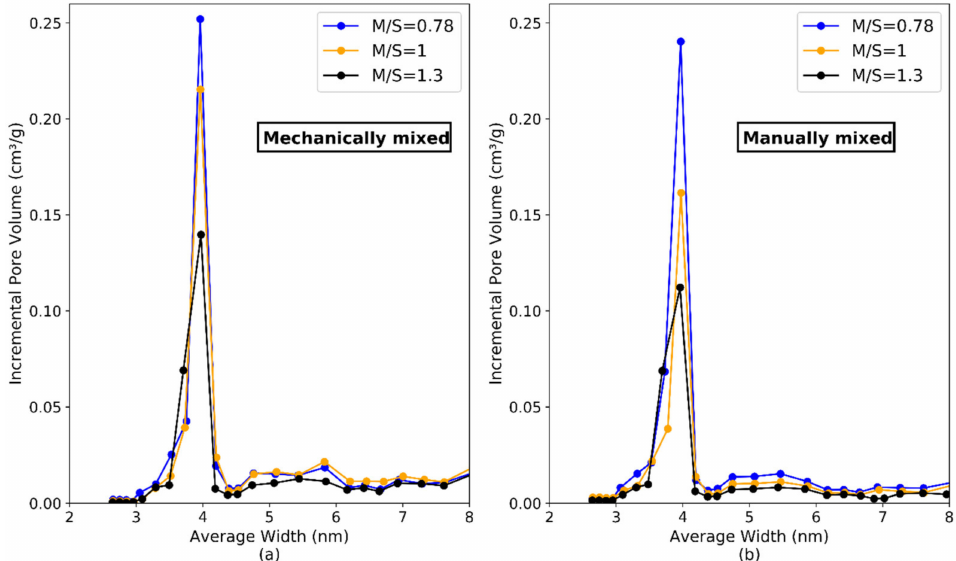
Figure 15. Pore size distribution by N 2 physisorption of M-S-H samples with M/S = 0.78, M/S = 1.0 and M/S = 1.3, mixed mechanically ( a ) or manually ( b